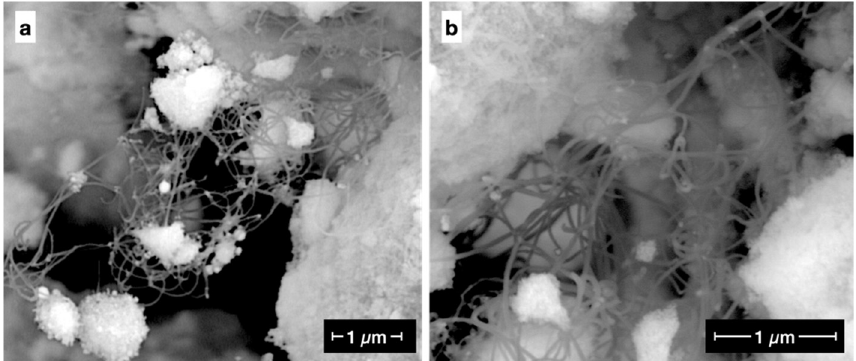
Figure 4. SEM images of the Ni/CeZrO 2 catalyst after toluene steam reforming carried out at S/C = 1.